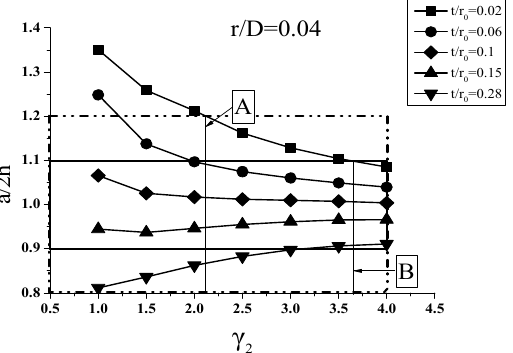
Figure 17. The relationship between a/2 h and γ 2 for r/D = 0.04.